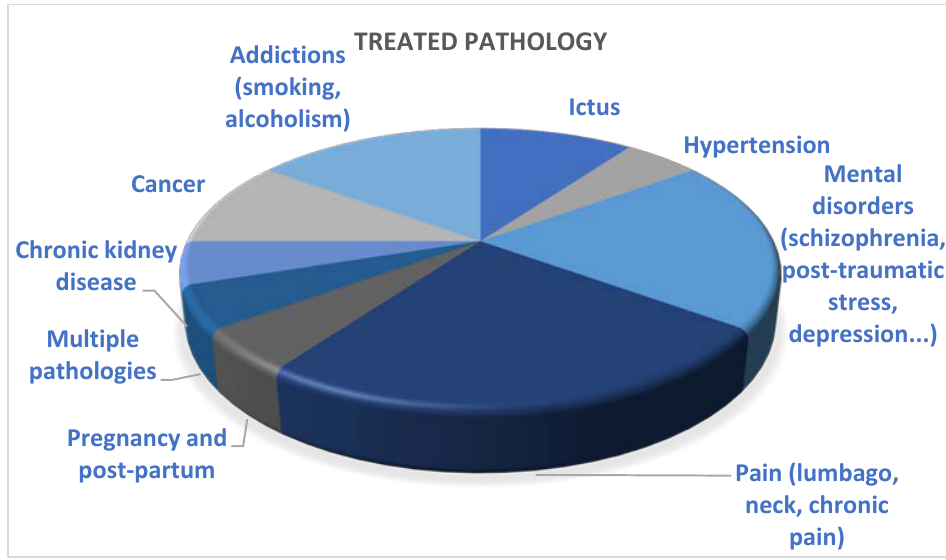
Figure 3. Treated pathologies in the reviewed papers.